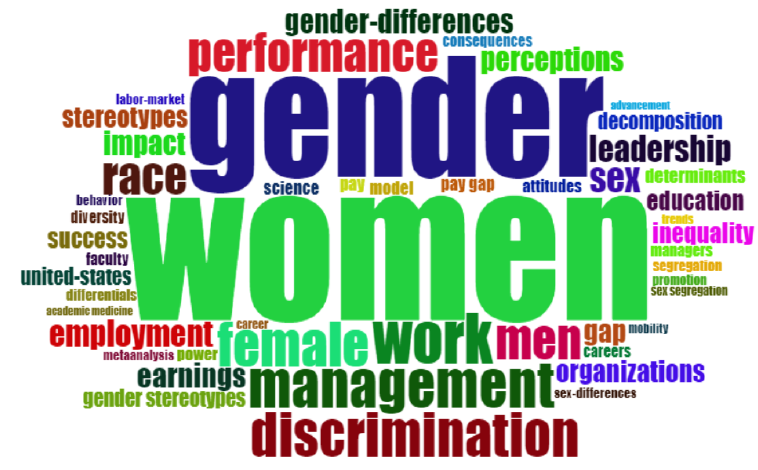
Figure 5. Word cloud.